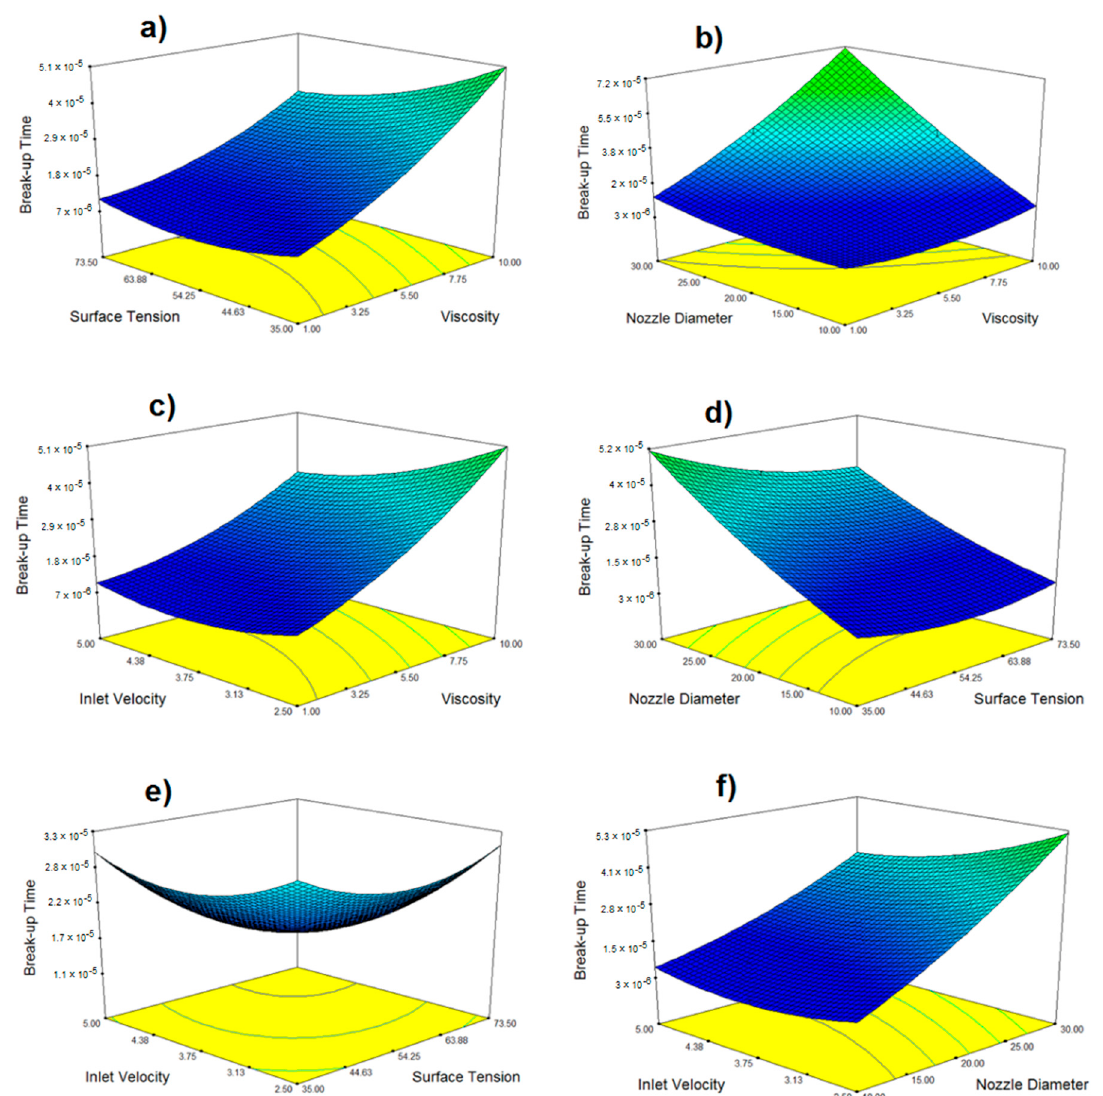
Figure 8. Contour response plots for break-up time as a function of ( a ) surface tension and viscosity, ( b ) nozzle diameter and viscosity, ( c ) inlet velocity and viscosity, ( d ) nozzle diameter and surface tension, ( e ) inlet velocity and surface tension, and ( f ) inlet velocity and nozzle diameter.